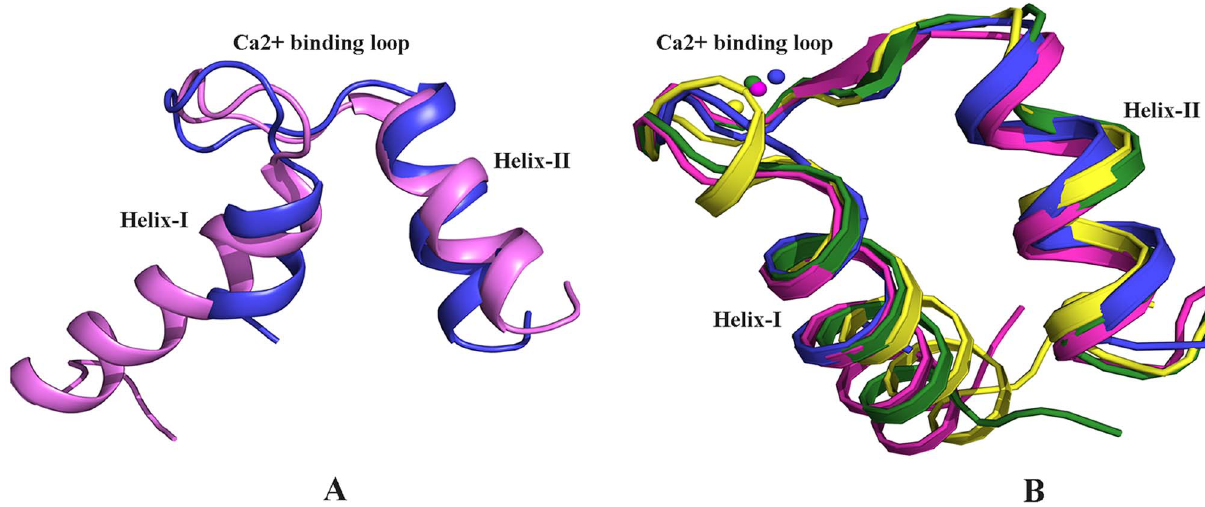
Fig 2. Structural comparison. A) Alignment of the Ca 2 + bound EF-hand motif of EhCaBP5 (blue) with that of Potato CaM (pink, pdb code 1RFJ). The r.m.s.d. of alignment is 2.38 A˚. The interhelical angles of the EF-hand motifs of EhCaBP5 and CaM are 64.3 A˚ and 89.3 A˚, respectively, indicative in turn of the closed and open conformations. (B) Alignment of the Ca 2 + bound EF-hand motif of EhCaBP5 (blue) with that of squid ELC (yellow, pdb code 1QVI), physarum ELC (green, pdb code 2BLO), and a mutant CaM (pink, pdb code 1Y6W). The rmsd’s of the alignments are1.6 A˚, 1.3 A˚ and 1.08 A˚, respectively.